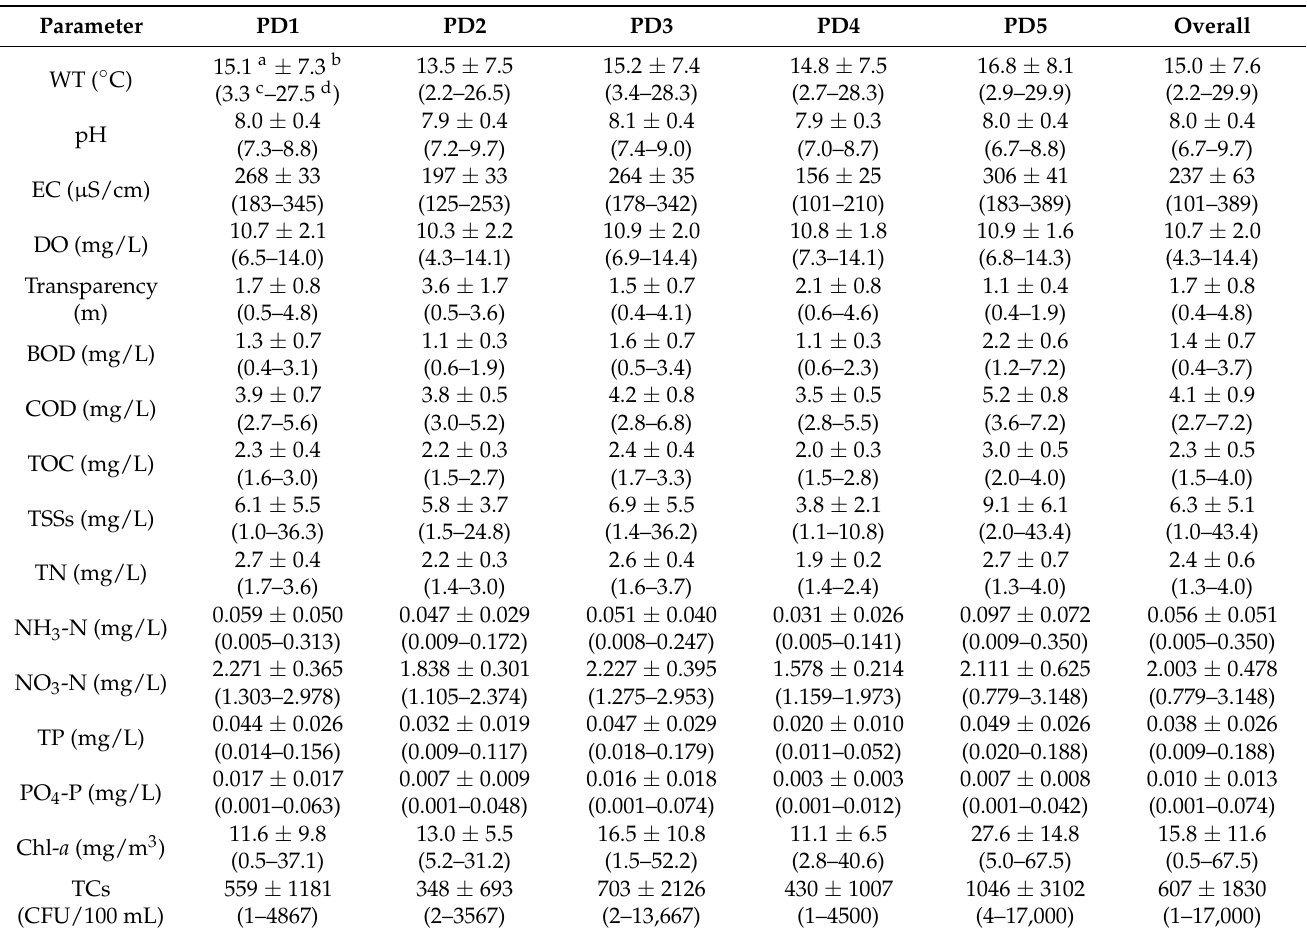
Table 3. Descriptive statistics summary of physicochemical and biological parameters in monitoring sites and overall PDR